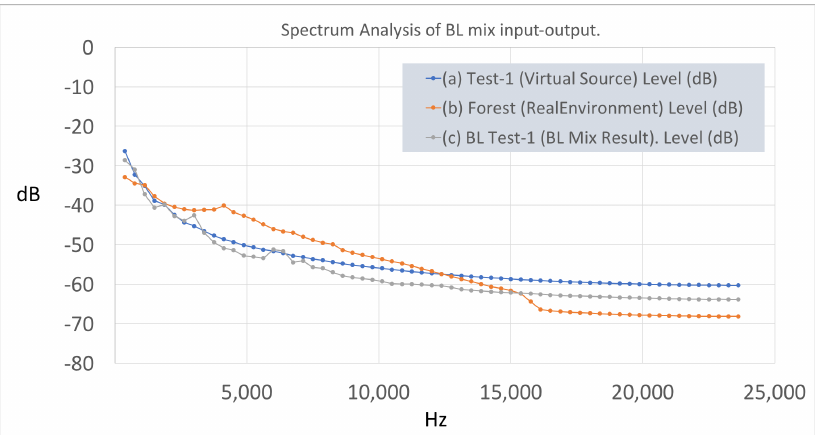
Figure 15. Spectrum Analysis of BL mix input-output. (a) Test-1 (virtual source). (b) Forest (real environment). (c) BL Test-1 ( BL mix